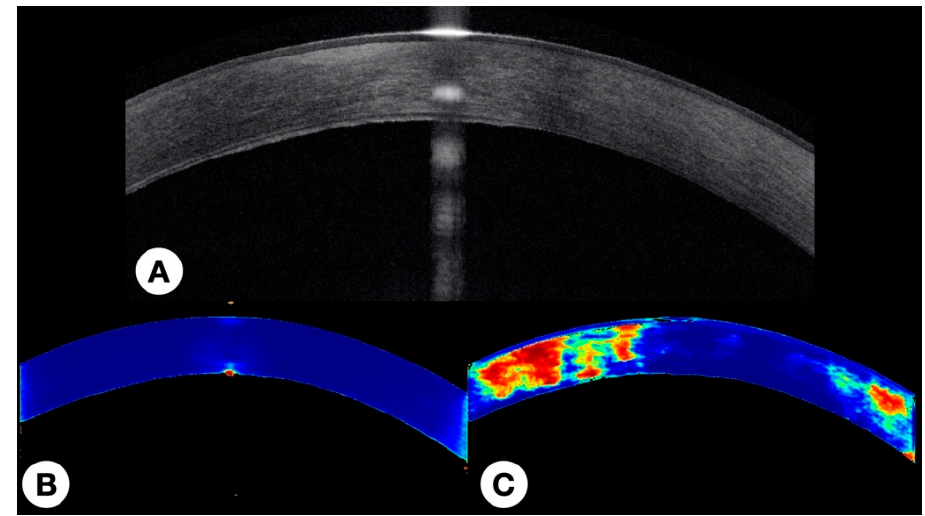
Figure 6. Example of an OCT image ( A ) from a patient with a DCCT of 87 μ m. Corresponding col ‐ ored heat map of the output probabilities of edema of our previous model ( B ) and of our current pipeline ( C ). Hotter colors indicate higher probabilities of edema. OCT: optical coherence tomogra ‐ phy; DCCT: differential central corneal thickness.